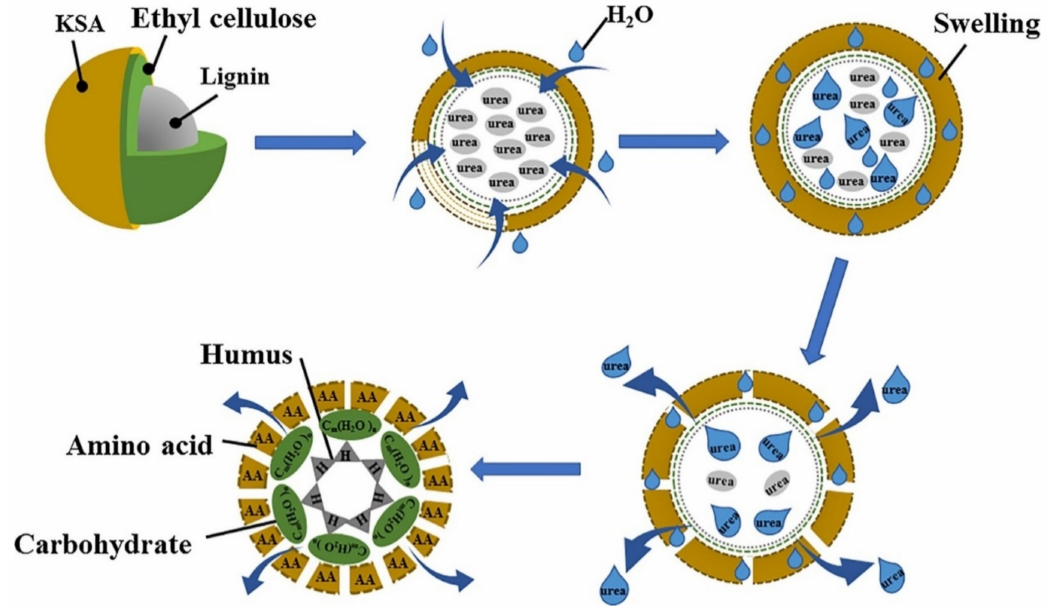
Figure 4. Schematic representation of keratin-based fertilizer nutrient release. Reprinted with permission from ref. [78]. 2022,